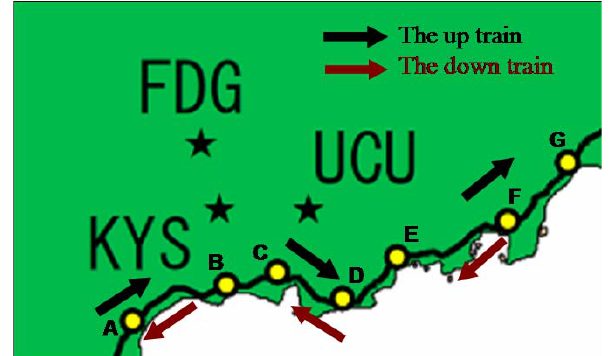
Fig. 20. The location of the stations and traveling directions of two trains used in Fig.